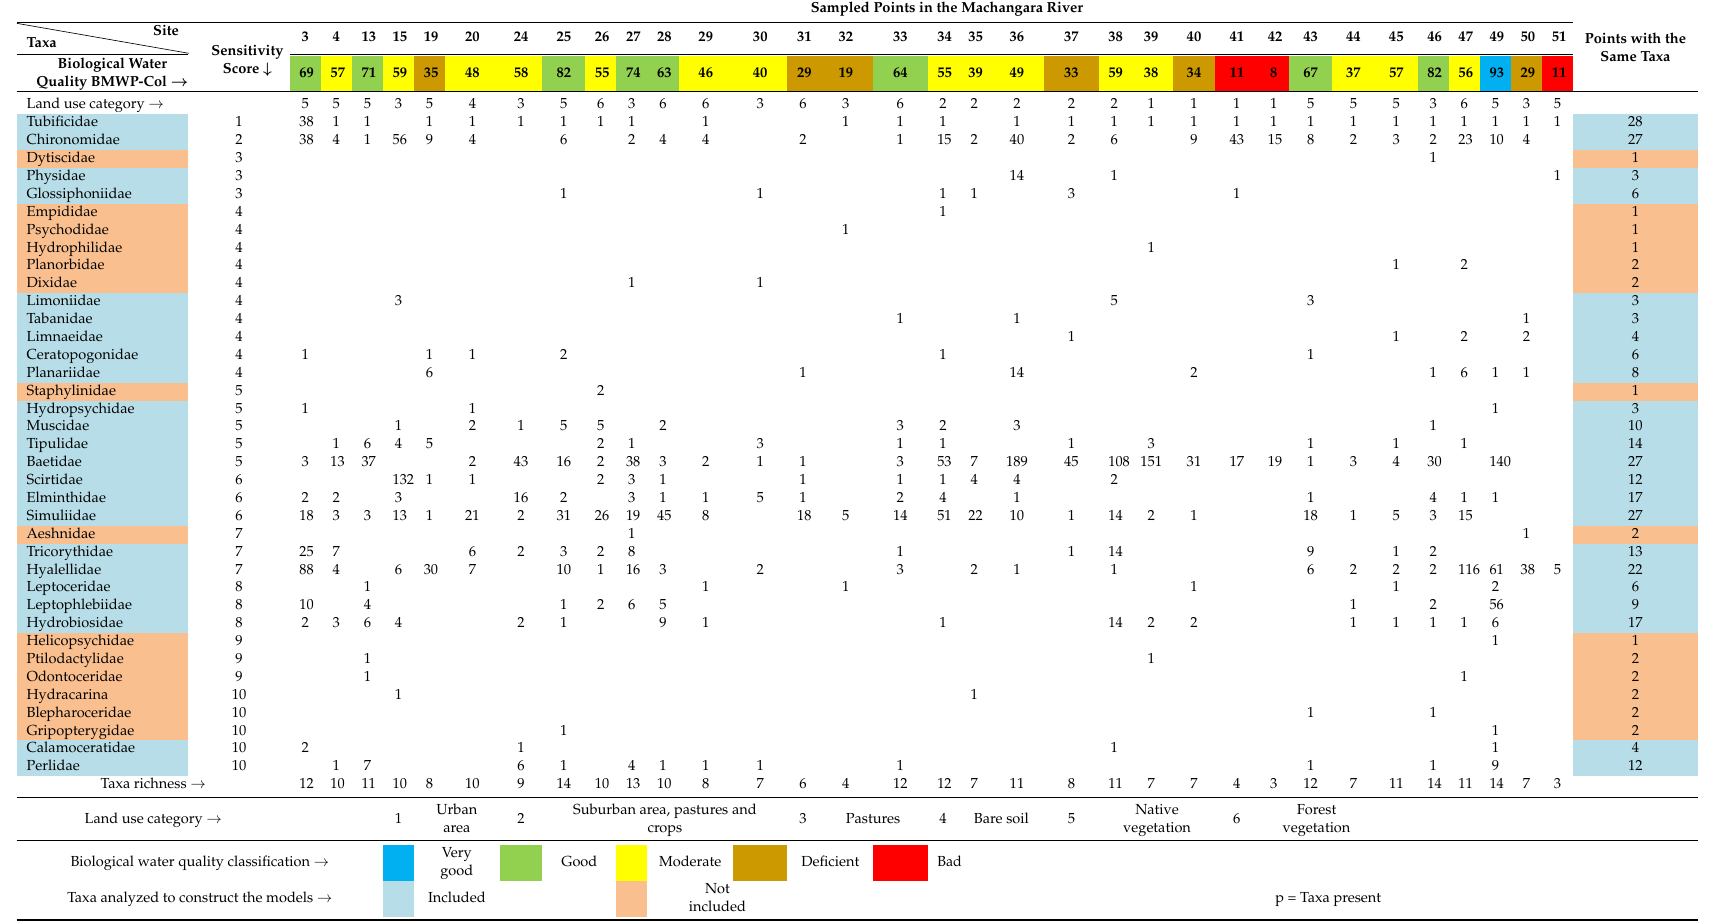
Table 2. Abundance of the taxa present in sampling sites in the Machangara River during February and March of